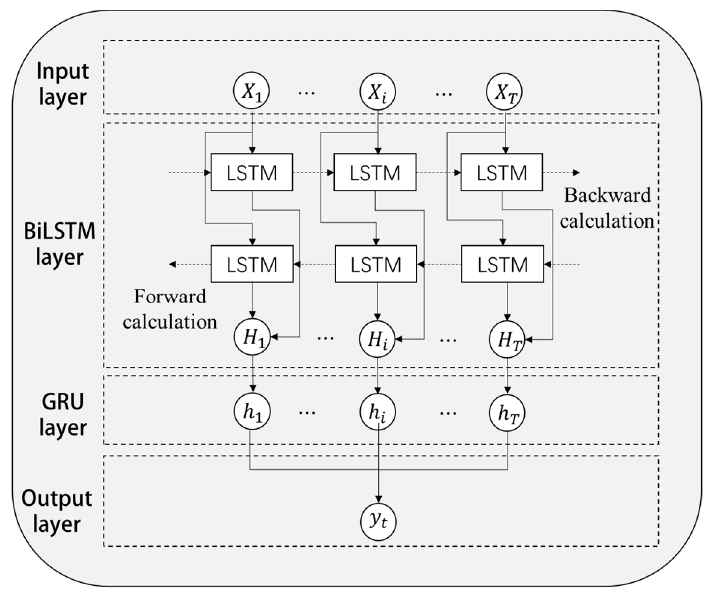
Figure 9. Structure of BiLSTM-GRU module.